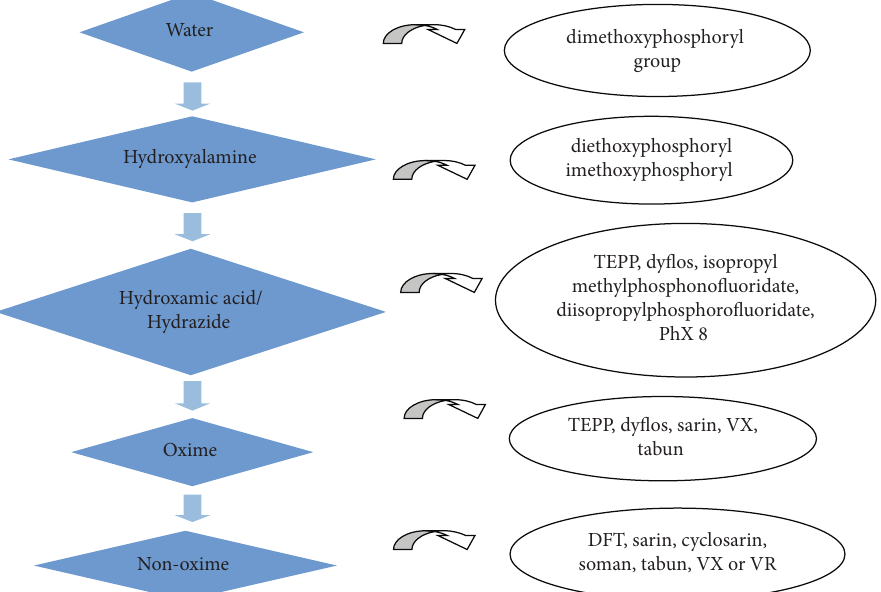
Figure 4: The development of OP-inhibited AChE reactivators and some of the inhibitors tested in the reactivation